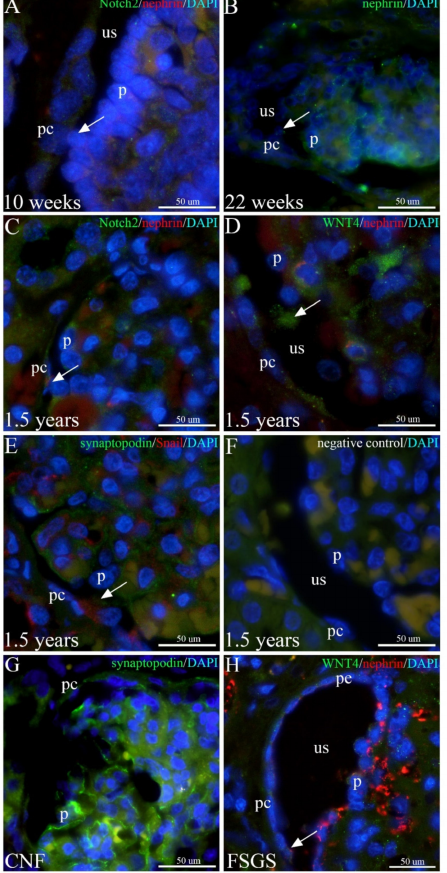
Figure 7. Expression of nephrin and synaptopodin and their co-expression with Notch2, WNT4, and Snail in developing, healthy postnatal human kidneys and kidneys affected by CNF and FSGS; podocytes (p), PECs (pc), peripolar cells (pe), urinary space (us). ( A ) 10th developmental week; Notch2 and nephrin co-localize in a cell (arrow) bridging the urinary space. ( B ) 22nd developmental week; nephrin expression characterizes the cytoplasm of a cell (arrow) bridging the urinary space. ( C ) Postnatal healthy kidneys; co-expression of Notch2 and nephrin is observed in the cytoplasm of the cell (arrow) connecting the glomerulus with PECs. ( D ) Postnatal healthy kidneys; strong expression of WNT4 is present in a cell bridging (arrow) the urinary space. ( E ) Postnatal healthy kidneys; co-localization of synaptopodin and Snail characterizes the cytoplasm of cells bridging (arrow) the urinary space. ( F ) Postnatal healthy kidneys; control staining characterized by omitting the primary antibody shows an absence of positive signals. ( G ) CNF kidneys; strong synaptopodin expression is visible in some podocytes. ( H ) FSGS kidneys; nephrin expression is present in some PECs